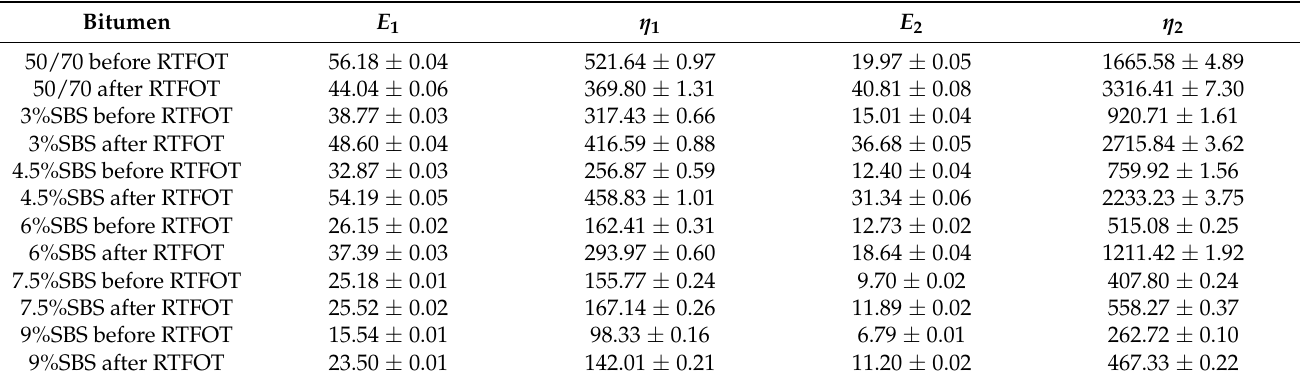
Table 8. Values of modulus of elasticity (parameters E 1 , E 2 ) and dynamic viscosity (parameters η 1 , η 2 ) in a modified generalized Maxwell model with four